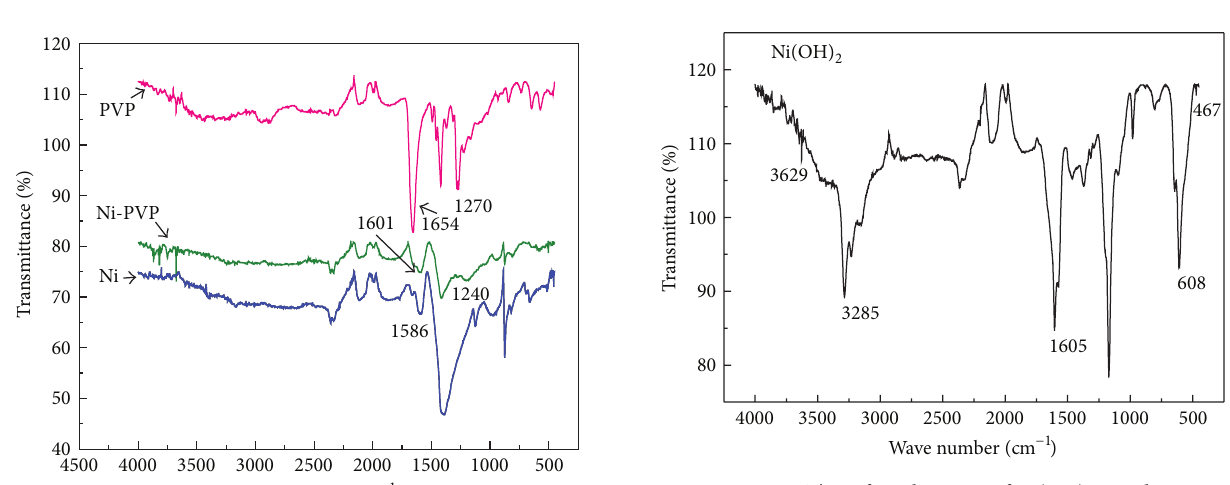
Figure 7: The infrared spectra of Ni(OH) 2